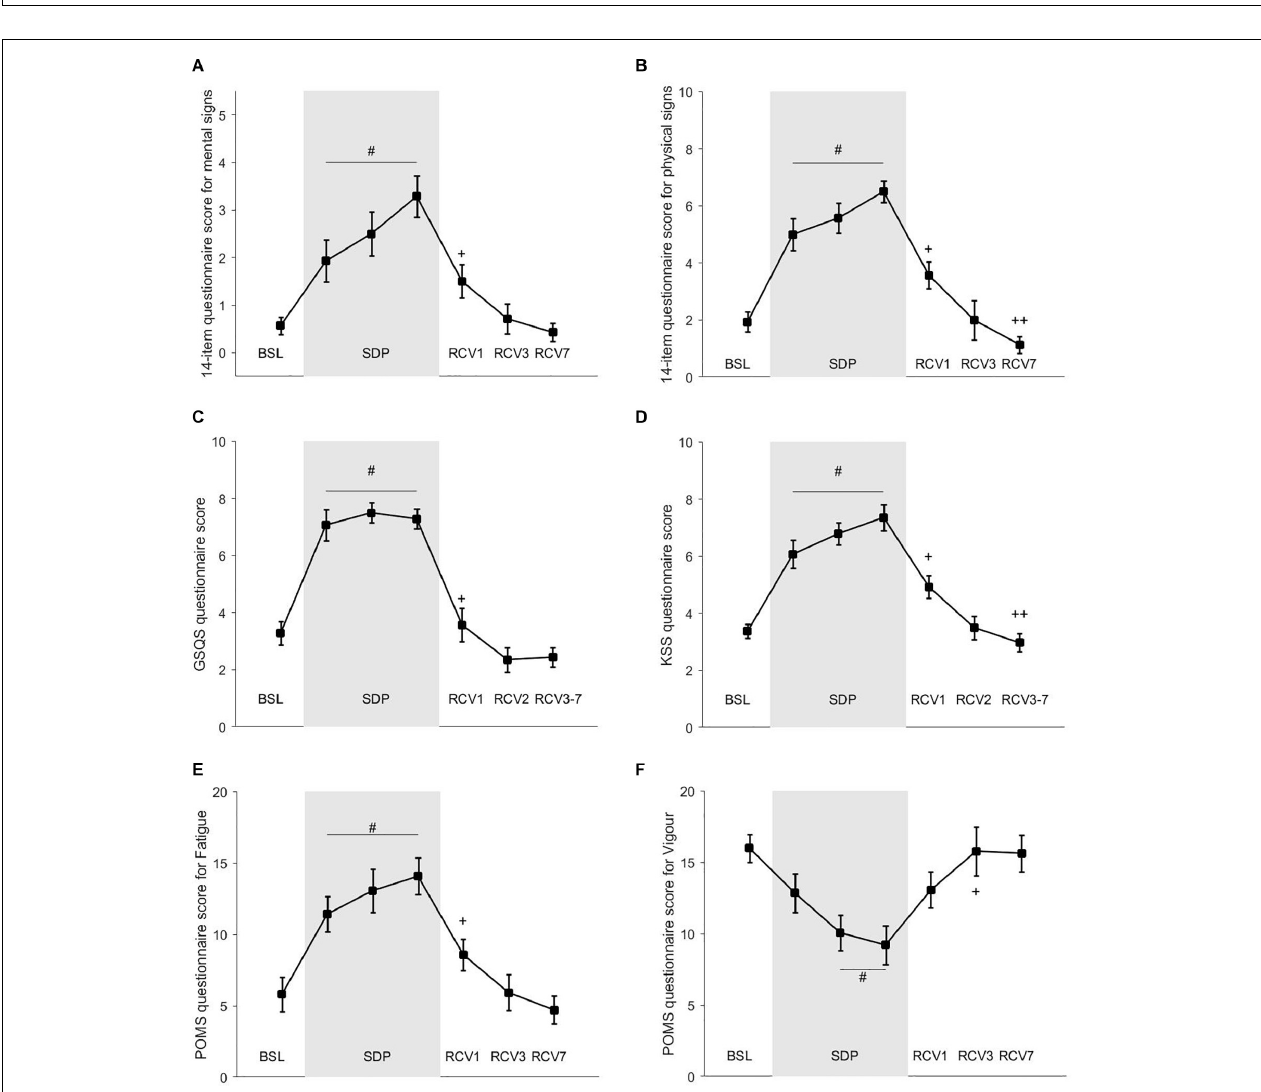
FIGURE 5 | Questionnaires’ scores. (A) 14-item questionnaire score for mental sign of fatigue; (B) 14-item questionnaire score for physical sign of fatigue; (C) GSQS questionnaire score; (D) KSS questionnaire score; (E) POMS questionnaire score for Fatigue; (F) POMS questionnaire score for vigor. # different from baseline (BSL; p < 0 . 05). + different from sleep deprivation (SDP)3 ( p < 0 . 05). ++ different from recovery (RCV)1 ( p < 0 .